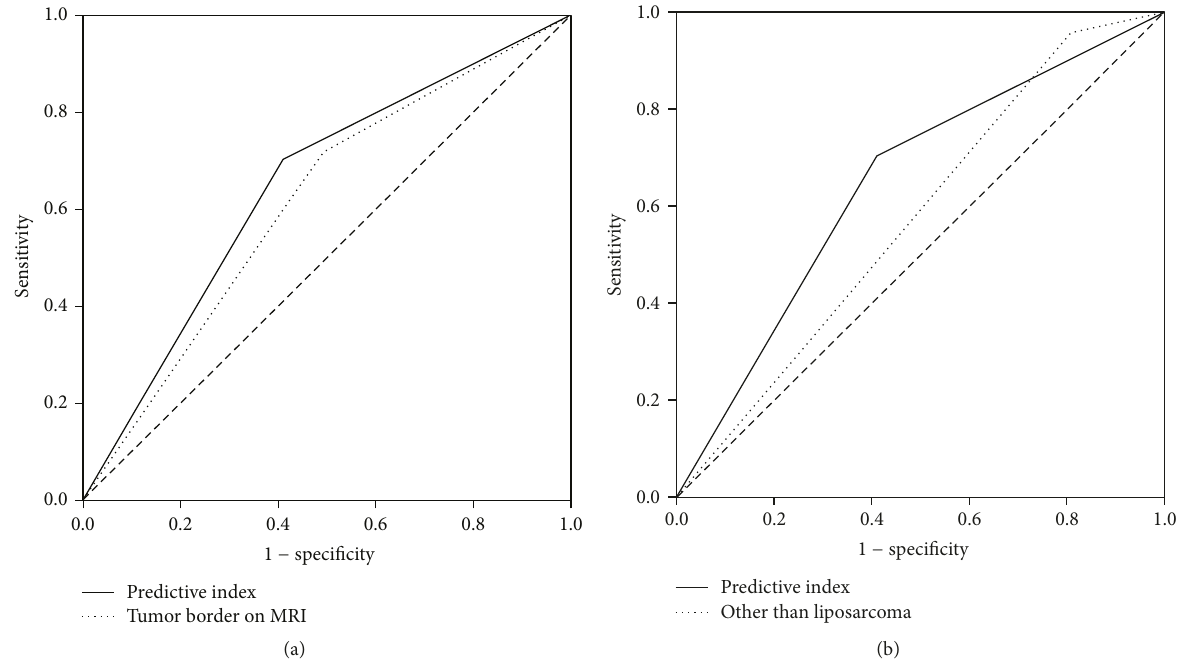
Figure 3: Pairwise AUC comparison of the predictive index and the tumor border on MRI alone or histological subtype other than liposarcoma alone in predicting infiltrative histologic growth pattern. (a) Pairwise area under the receiver-operating curve (AUC) comparison of the predictive index and the tumor border on MRI alone in predicting infiltrative histological growth pattern. (b) Pairwise area under the receiver-operating curve (AUC) comparison of the predictive index and histological subtype other than liposarcoma alone in predicting infiltrative histological growth pattern. AUC, area under the curve. The dashed line in both graphs represented random guess to predict (AUC =